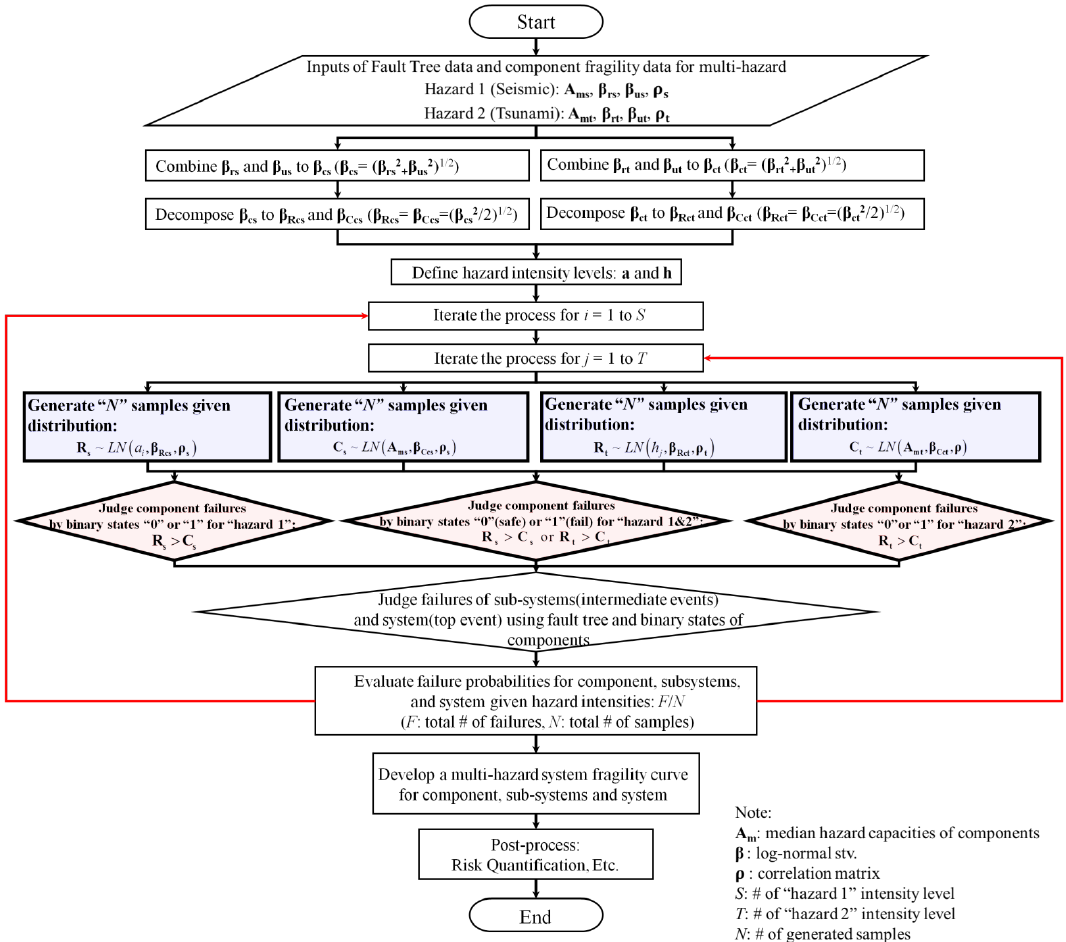
Figure 1. Flowchart of extended DQFM algorithm for multi-hazard risk assessment.